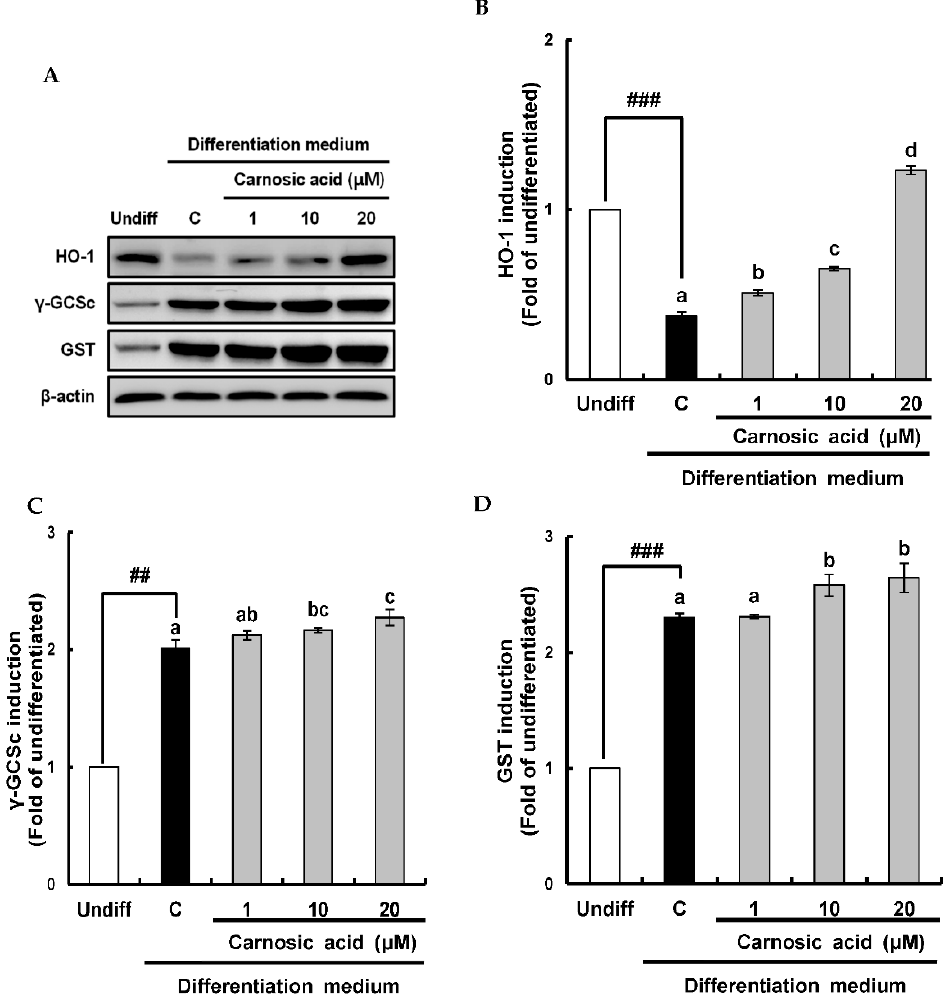
Figure 5. Effects of carnosic acid on the translation of phase II antioxidant enzyme during MDI- induced differentiation of 3T3-L1 pre-adipocytes to adipocytes for two days. ( A ) Translation of phase II antioxidant enzyme by Western blotting analysis after differentiation for two days. ( B ) Graphic representation of densitometric analysis of HO-1 blot. ( C ) Graphic representation of densitometric analysis of phosphorylated γ -GCSc blot. ( D ) Graphic representation of densitometric analysis of GST blot. Data are presented as averages of three independent experiments performed in triplicates and expressed as percentages of the value of the control (means ± standard error mean, n = 3). ## : p < 0.01 and ### : p < 0.001 vs. Undiff. Different corresponding letters indicate significant differences using Student’s t -test. (Undiff: undifferentiated, which was not treated with the MDI hormone mixture; C: control, which was treated with the MDI hormone mixture).